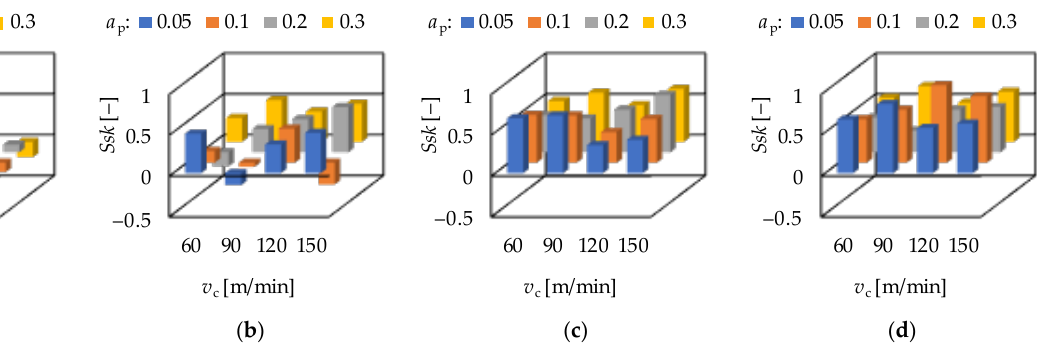
Figure 8. The measured maximum valley depth ( Sv ) values for hard turning by applying ( a ) f = 0.05 mm/rev, ( b ) f = 0.1 mm = rev, ( c ) f = 0.15 mm/rev, ( d ) f = 0.2 mm/rev. If the skewness ( Ssk ) value is zero or decreasing, both the wear resistance and the fluid-retention ability increase. Concerning the hard turning procedure, on lower feed rate lower Ssk values were obtained, relatively close to or below zero. There were no clear tendencies observed for the effects of the cutting speed or the depth-of-cut (Figure 9). The kurtosis ( Sku ) informs about the wear resistance.